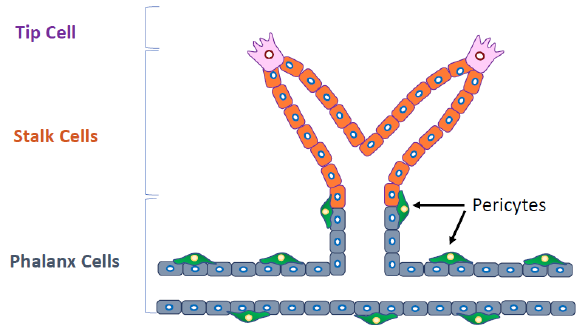
Figure 2. Several types of endothelial cells (ECs) are involved in angiogenesis. Cells at the tip of the formed blood vessels. Pericytes attach to phalanx cells (black arrows). blood vessel branch (tip cells) guide the direction of vessel sprouting. Stalk cells, which are highly proliferative, follow tip cells, and phalanx cells improve the perfusion and oxygenation of newly formed blood vessels. Pericytes attach to phalanx cells (black arrows). formed blood vessels. Pericytes attach to phalanx cells (black